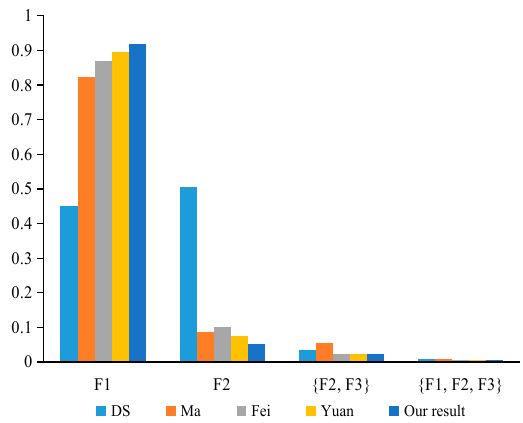
Figure 7. The comparison of the fusion results in different methods.